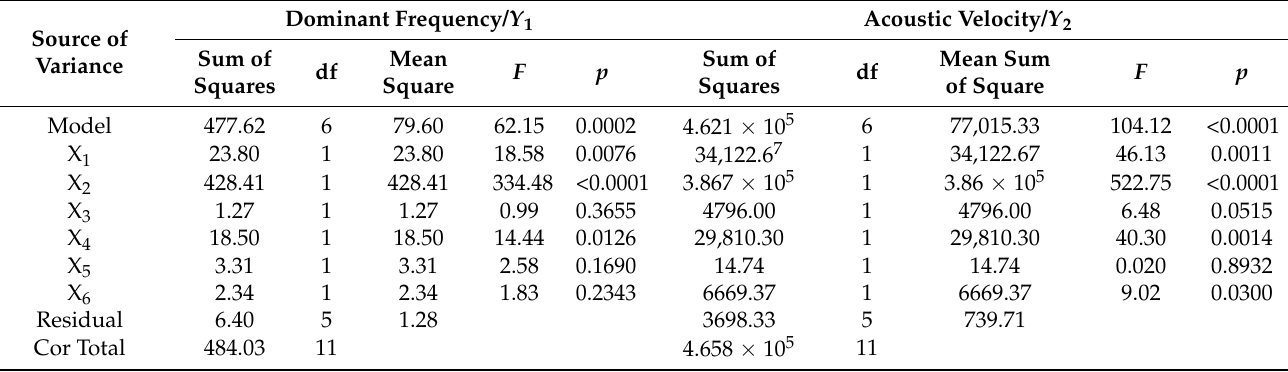
Table 6. Analysis of variance of Plackett—Burman